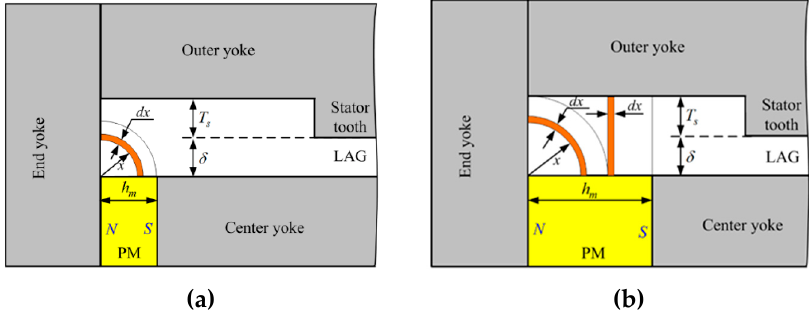
Figure 4. Models of permanent magnet (PM)-to-yoke magnetic flux leakage: ( a ) Circular-arc model for the case of h m < T s + δ ; ( b ) circular-arc and straight-line model for the case of h m > T s + δ .